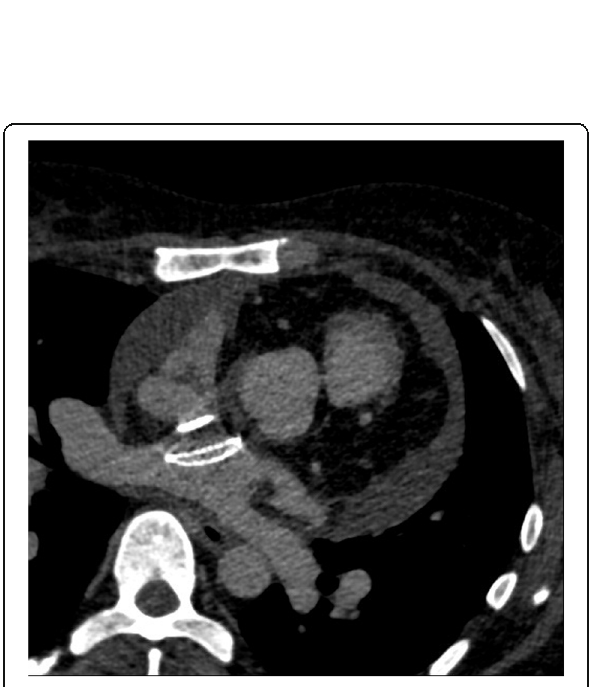
Fig. 3 CT angiography showed that ASO device was in proper position through the interatrial septum and there was a retroaortic hematoma due to cardiac